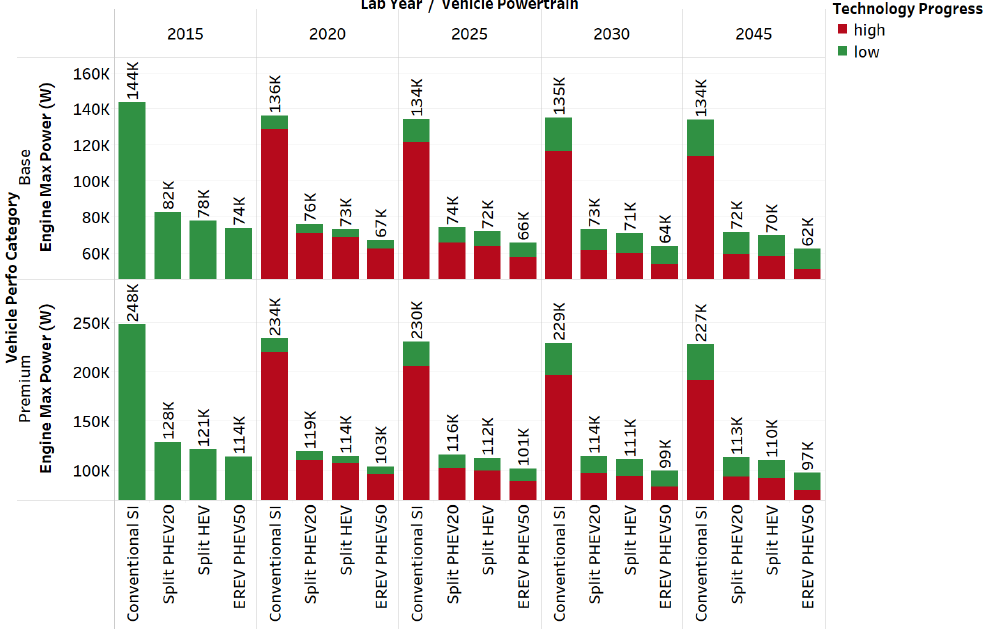
Figure 6. Engine peak power for midsize